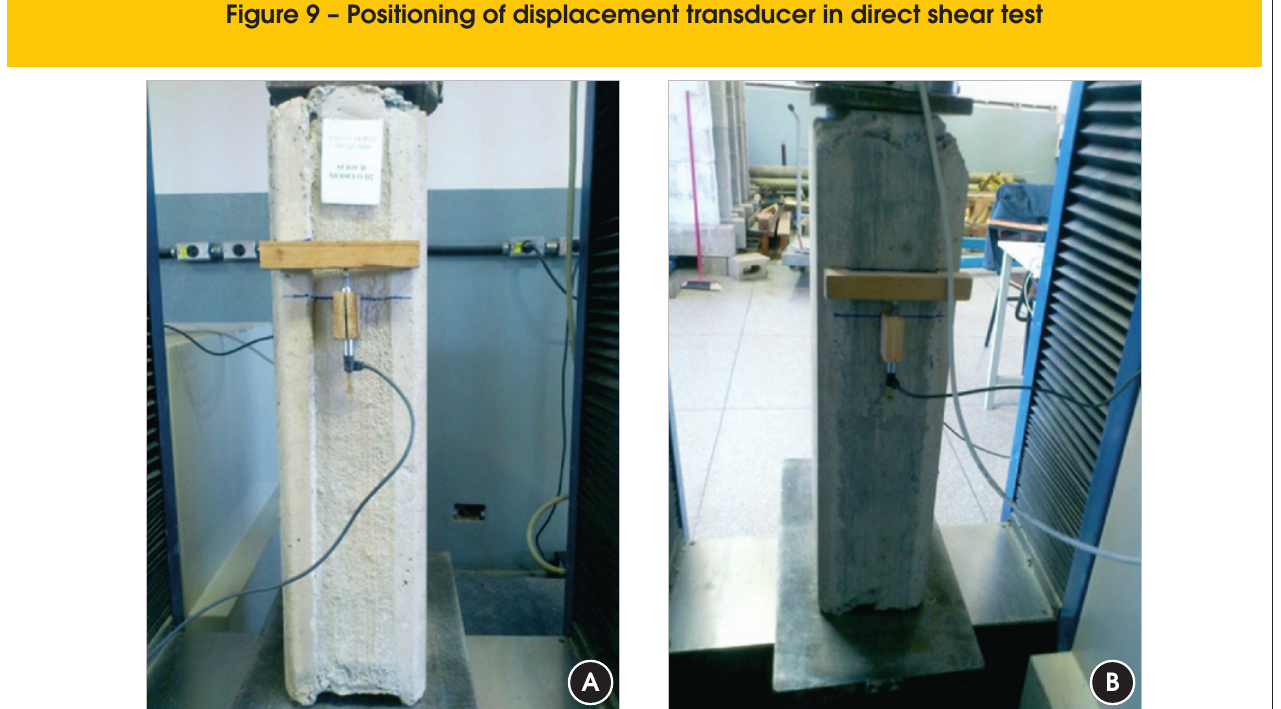
A B Transducer positioned on side A (front view) Transducer positioned on side B (back